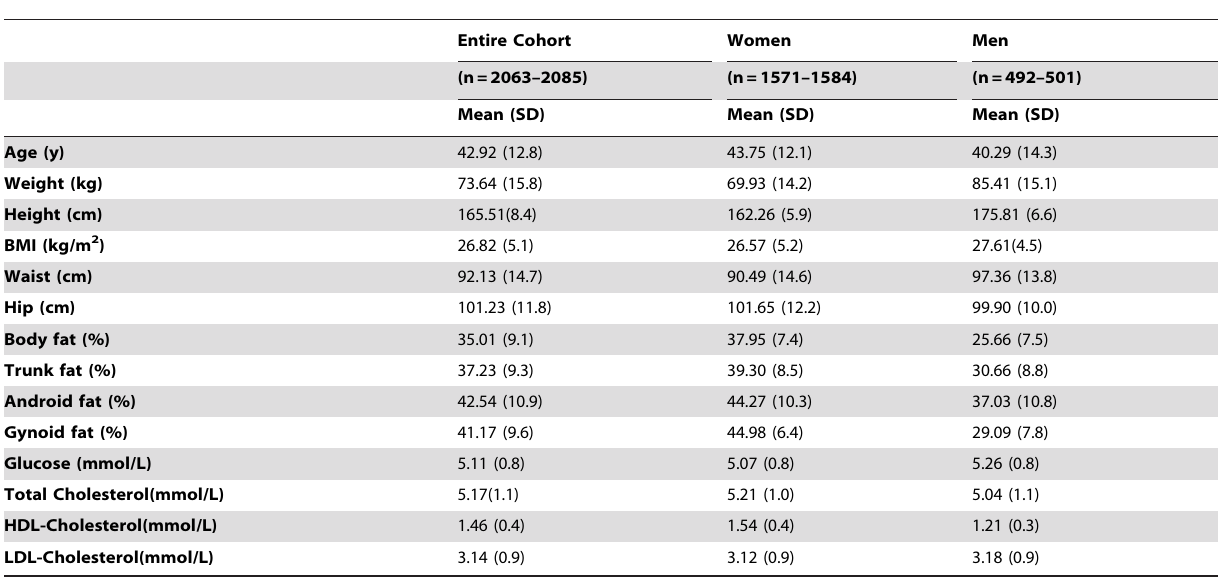
Table 1. Biochemical and body composition characteristics 1